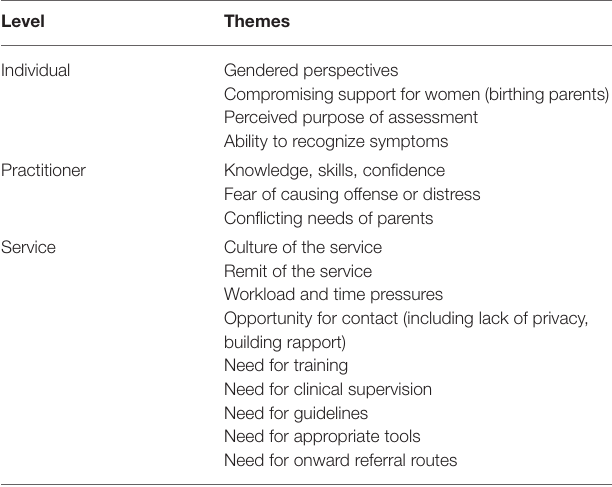
TABLE 3 | Summary of themes: challenges associated with mental health assessment of fathers, other co-parents and